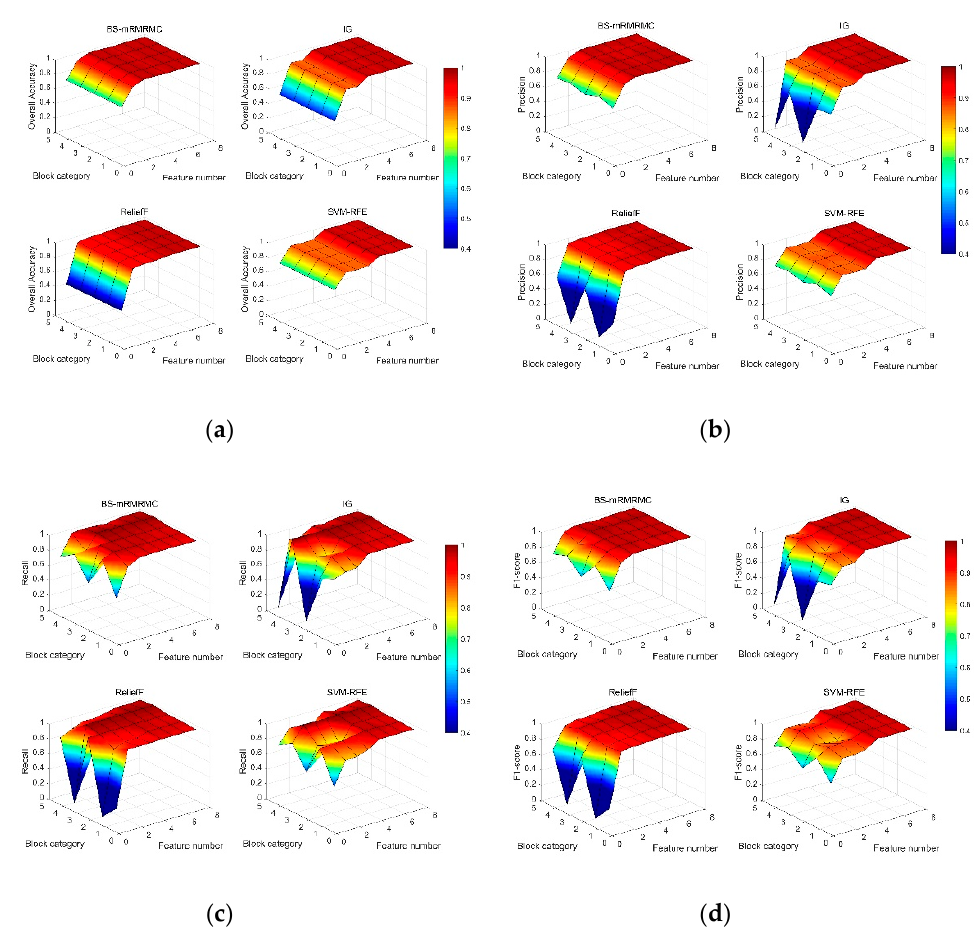
Figure 12. Under different number of features, the evaluate indicator surface graph of the four methods identify each category. ( a ) The overall accuracy, ( b ) the accuracy, ( c ) the recall rate, and ( d ) the comprehensive evaluation indicator f1-measure; where block category 0, ... ,4 respectively represents no blocking, water blocking, people blocking, metal blocking and wall blocking).